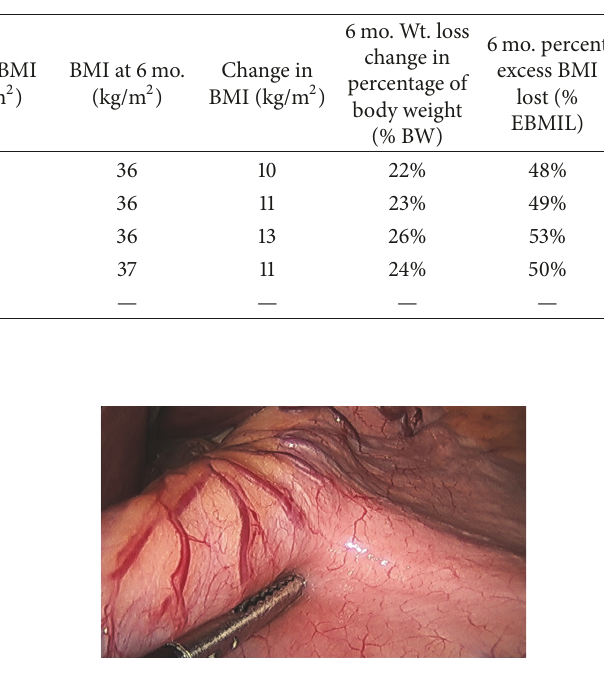
Table 2: Leak incidence and weight loss results.